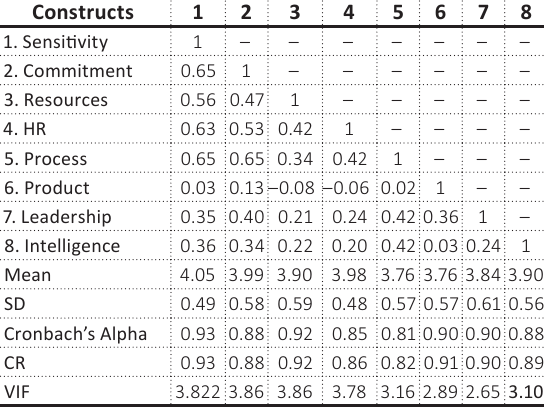
Table 2. Correlation matrix and descriptive